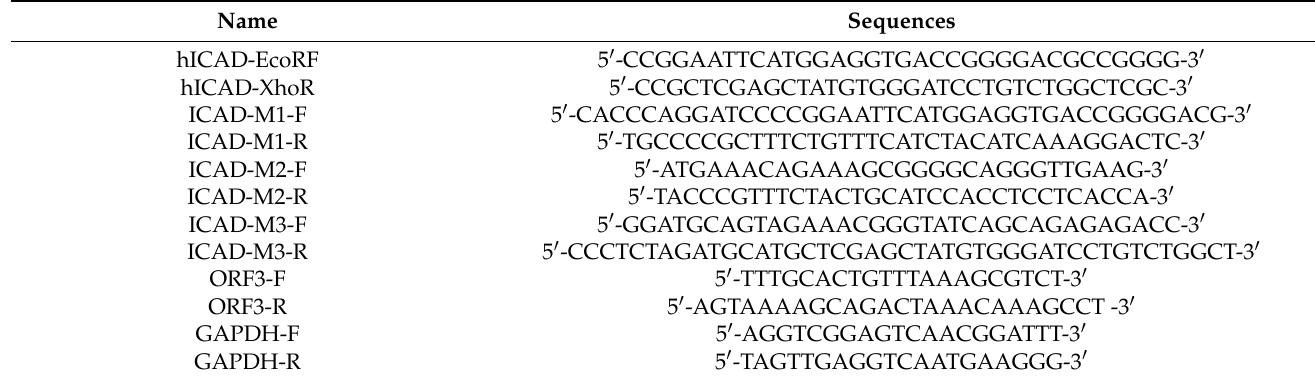
Table 1. The sequences of primers were used in this